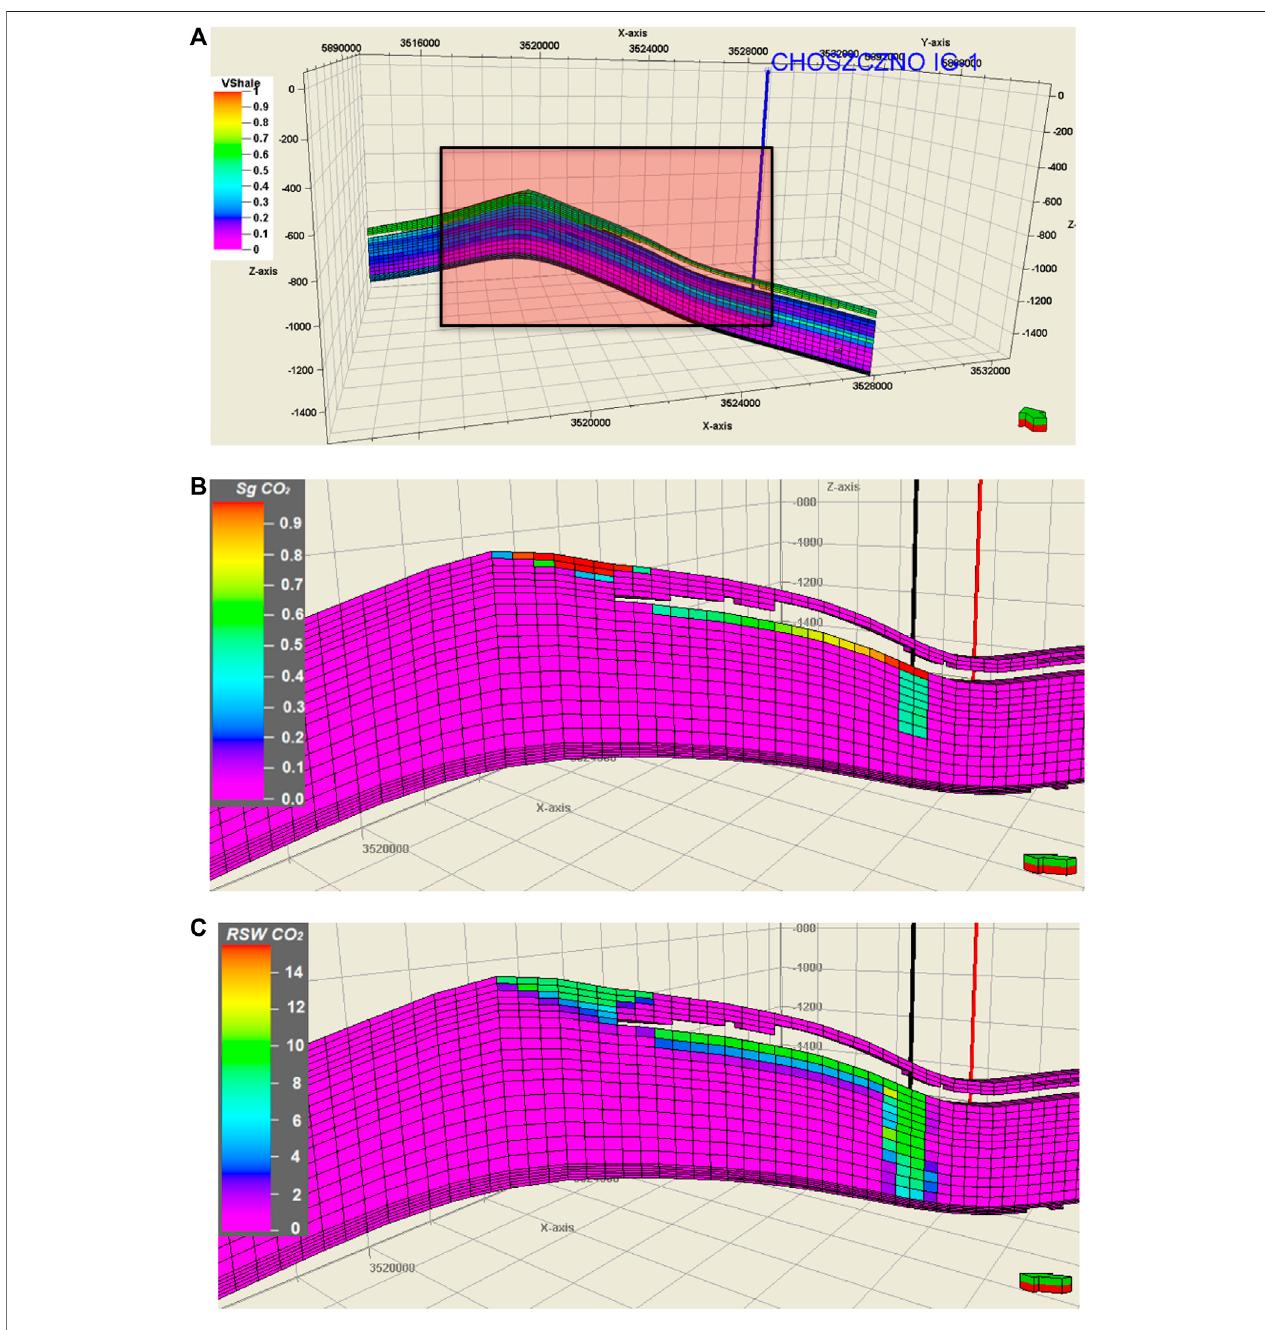
FIGURE 9 | The determined fragment of the section enlarged in the following Figures (A) , the distribution of free CO 2 saturation in the structure (B) and the distribution of CO 2 saturation dissolved in brine (c) after 25 years of